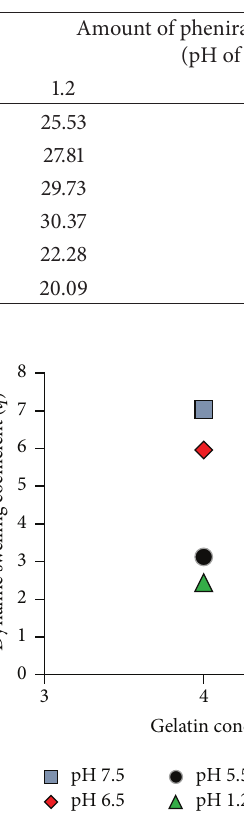
Figure 5: Dynamic swelling coefficient of AA/Gelatin hydrogels with different concentration of gelatin (4.0, 5.0, and 6.0gm) using EGDMA as cross-linking agent (0.7%) of acrylic acid in 0.05 M USP phosphate buffer solutions of different pH values at 37 ∘